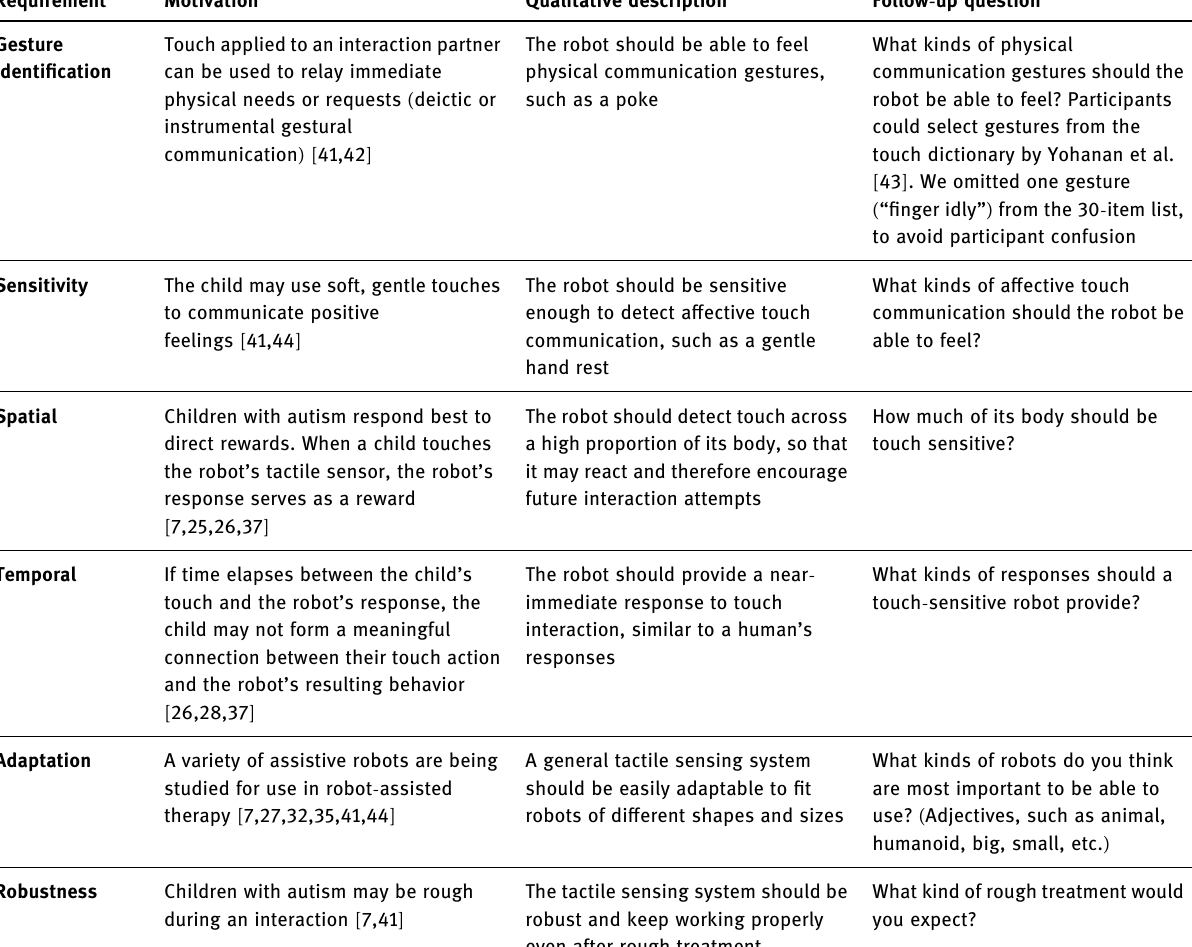
Table 1: Initial list of six touch - sensing requirements that we derived from the literature. Speci fi c sources that inspired each requirement are cited in the “ Motivation ” column. Study participants viewed the requirement name, motivation, and qualitative description; they then ranked the requirements in order of importance and gave feedback about each one and the entire list. For each requirement, we also show the follow - up question that the experimenter asked to spark additional feedback after completion of the ranking task Requirement